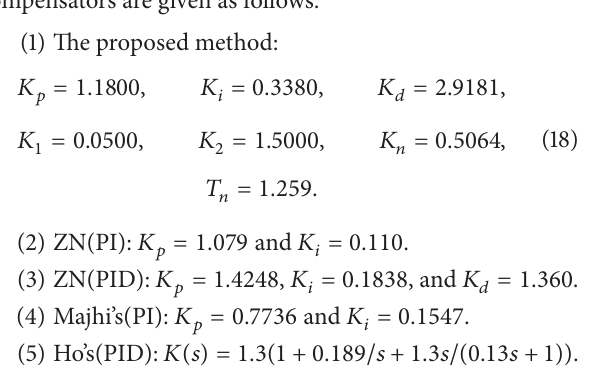
[17] for finding PI compensator. Parameters of five found compensators are given as